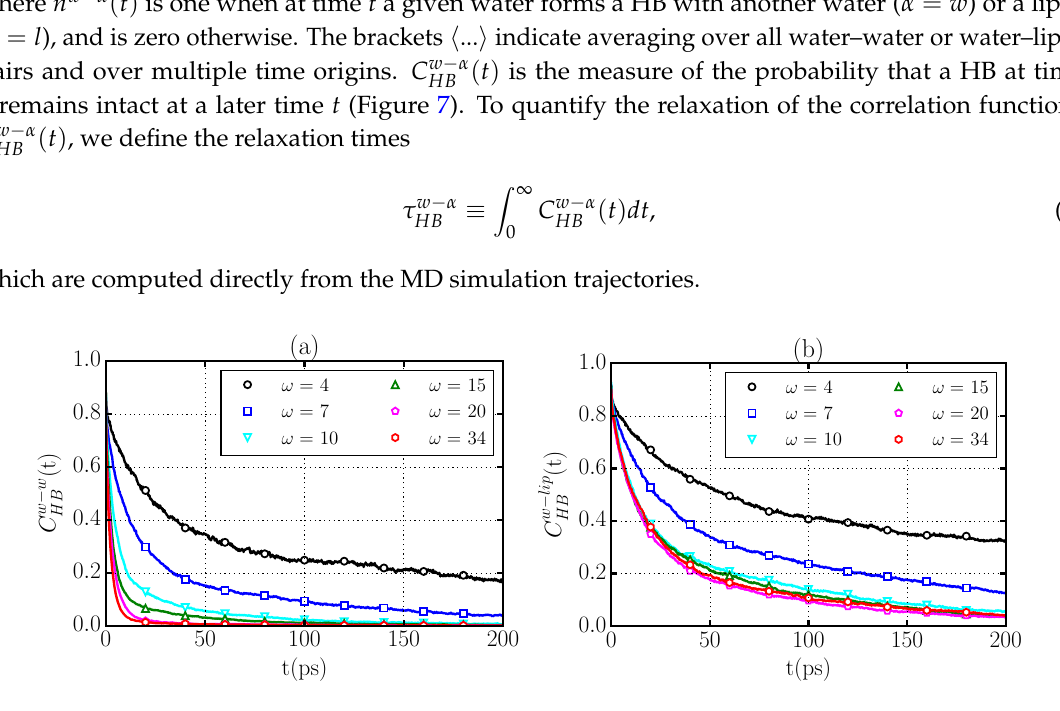
Figure 7. Relaxation of the time correlation functions C w − w phospholipid membranes with hydration levels ω = 4 ( black circles), ω = 7 ( blue squares), ω = 10 ( cyan triangles down), ω = 15 ( green triangles up), ω = 20 ( pink pentagons), ω = 34 ( red